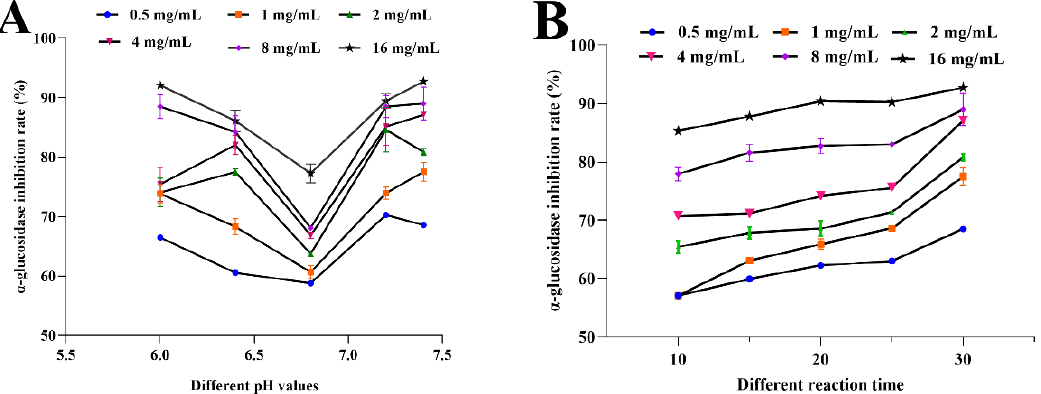
Figure 4. Effect of different pH and time on α -glucosidase activity. Effect of different pH values ( A ) and time ( B ) on α -glucosidase activity.